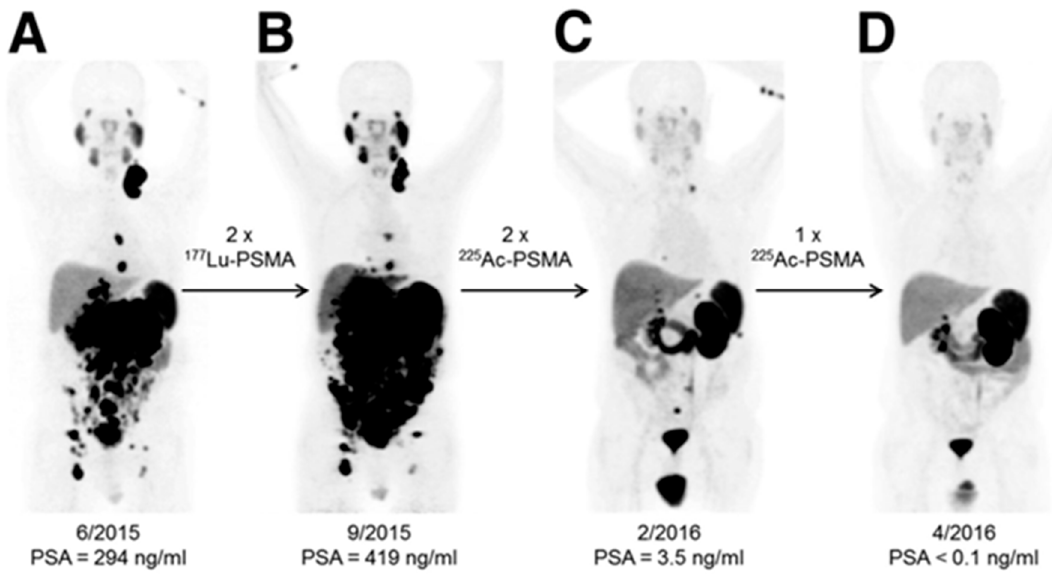
Figure 5. Alpha ( α )-particle therapy overcomes β -resistant cancer. This imaging was performed using Ga-68-PSMA-11 PET/CT scanning. Kratochwil, C. et al. [49] reports, “In comparison to initial tumor spread ( A ), restaging after 2 cycles of β -emitting 177 Lu-PSMA-617 presented progression ( B ). In contrast, restaging after second ( C ) and third ( D ) cycles of α -emitting 225 Ac-PSMA-617 presented impressive response.” This research was originally published in The Journal of Nuclear Medicine [49].